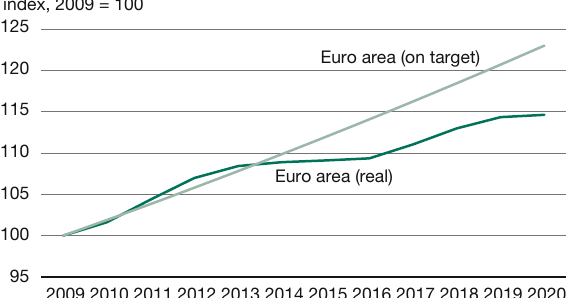
Note: Annual data for the euro area with changing composition: EMU16- 2009, EMU17-2011, EMU18-2014, EMU19-2015. Source: Eurostat, own calculations. Figure 2 The EMU Phillips curve with output gap